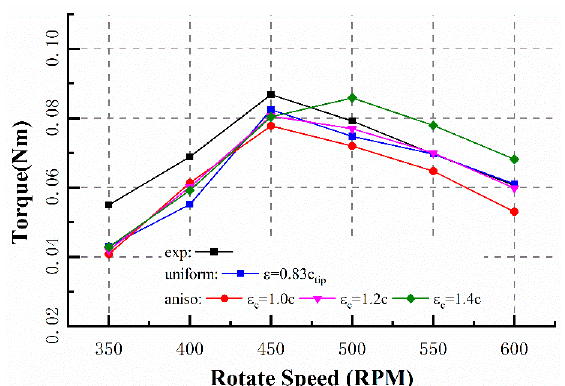
Figure 12. The comparison of torque between experiment, simulation using standard regularization kernel with ϵ = 0.83c (cid:2930)(cid:2919)(cid:2926) , and simulations using anisotropic regularization kernel with different ϵ (cid:2913) values.